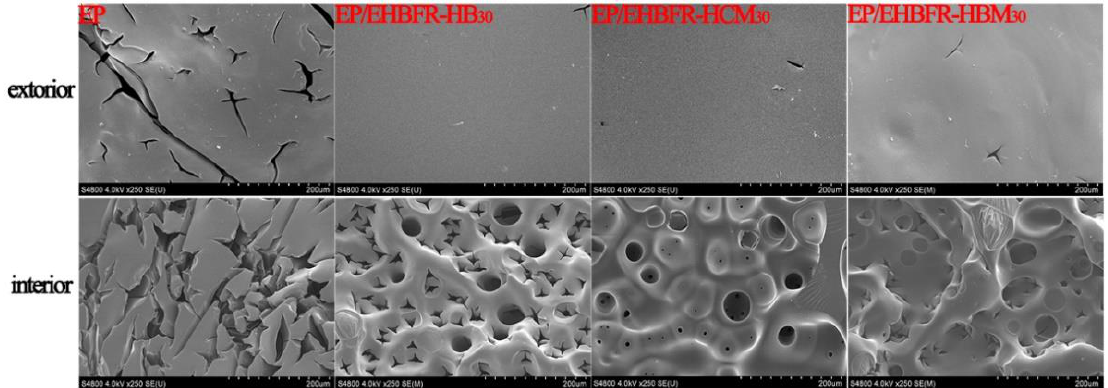
Figure 8. SEM micrographs of char residues after the UL-94 test: external char residues and internal char residues.